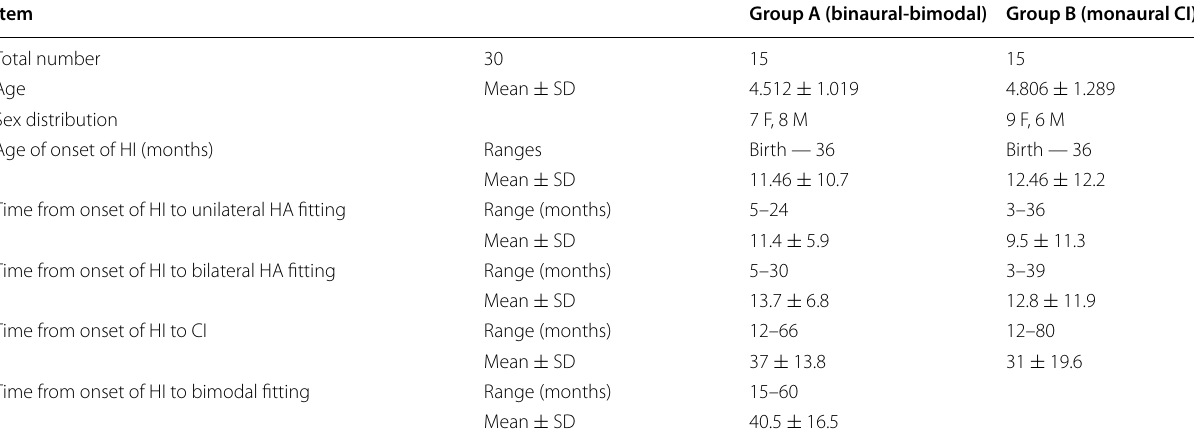
Table 1 Participants’ personal and treatment